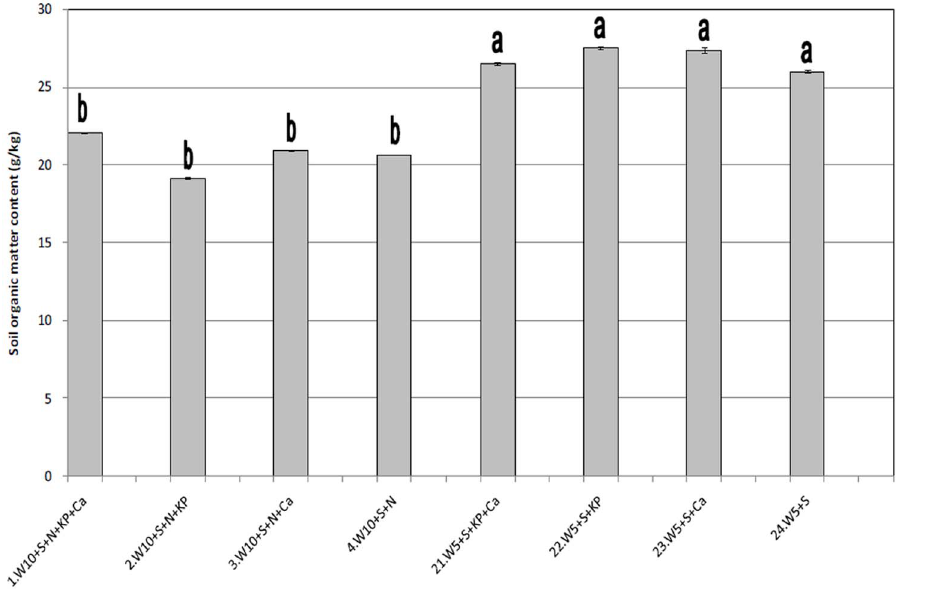
Figure 3. Soil organic matter content of the cyanobacterial crust layer in the treatments with the highest (21–24) and lowest (1–4) measured biomass. Note: Different letters above the bars indicate significant differences ( P , 0.01) between treatments.